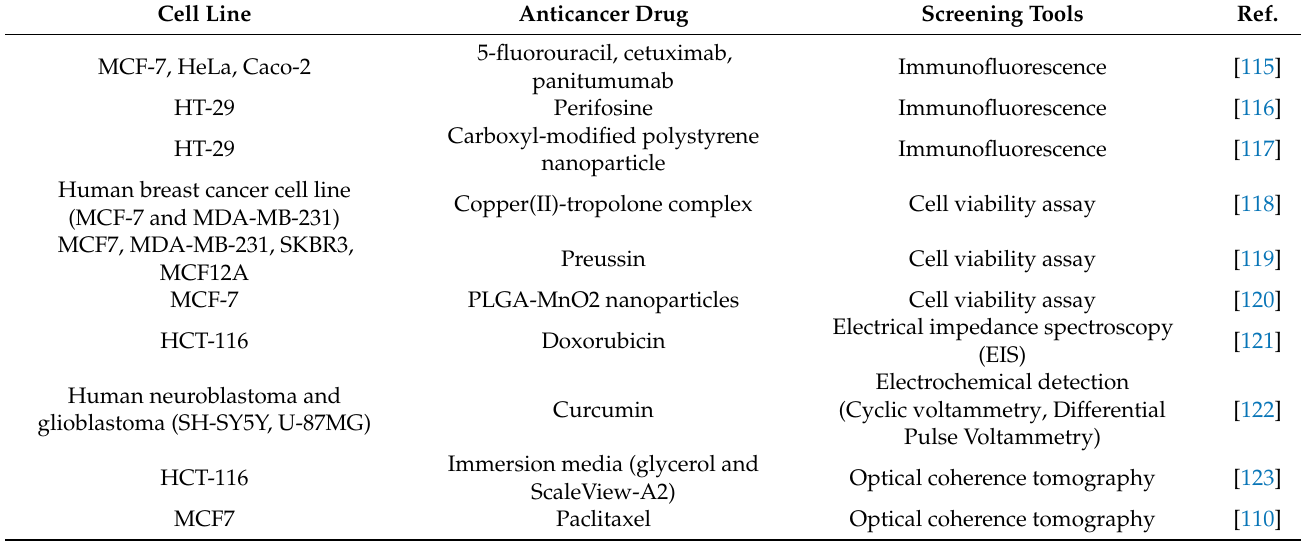
Table 2. Drug-screening methods for multicellular cancer